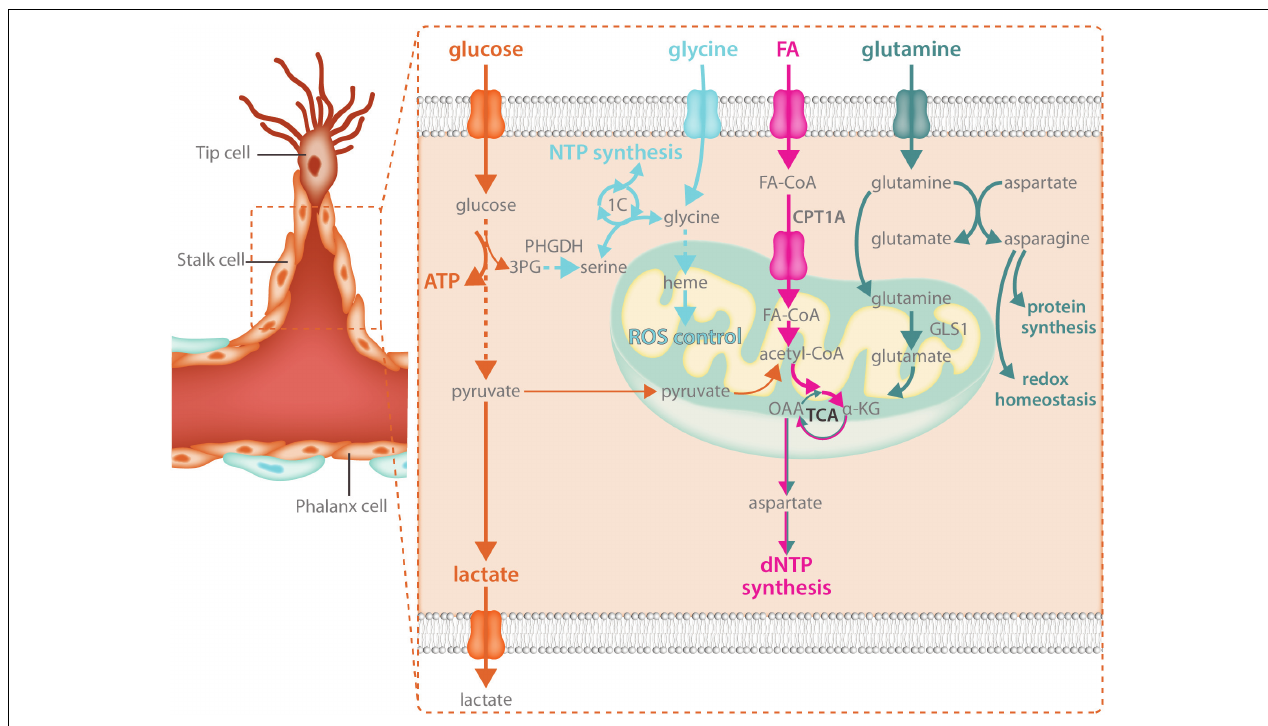
FIGURE 3 | Stalk cells use fatty acid oxidation and amino acid metabolism for biomass synthesis. Like all endothelial cells, stalk cells rely heavily on glycolysis for ATP production. Fatty acid oxidation and amino acid metabolism are required to produce the macromolecules necessary for stalk cell proliferation. Carbon derived from fatty acid oxidation and glutamine catabolism contribute to nucleotide synthesis while glutamine and asparagine catabolism contribute to both protein synthesis and maintenance of redox homeostasis. The intracellular serine synthesis pathway links glucose metabolism with amino acid metabolism in stalk cells for the production of NTPs as well as heme synthesis, which maintains mitochondrial function and controls ROS